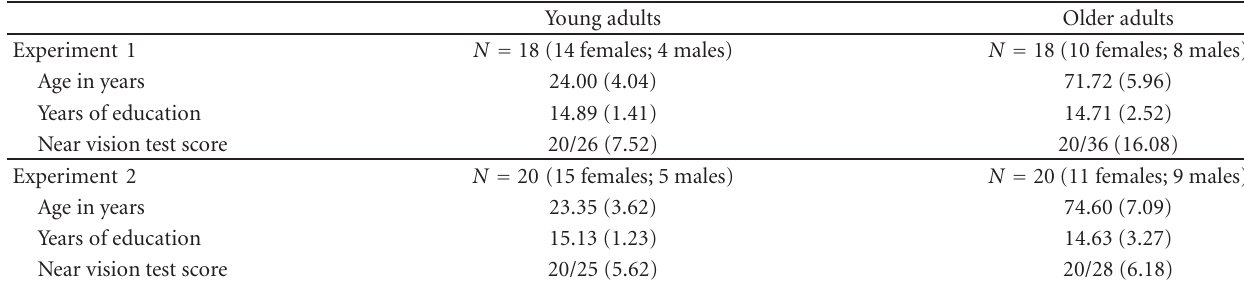
Table 1: Participant characteristics in Experiments 1 and 2 (SDs in parentheses).